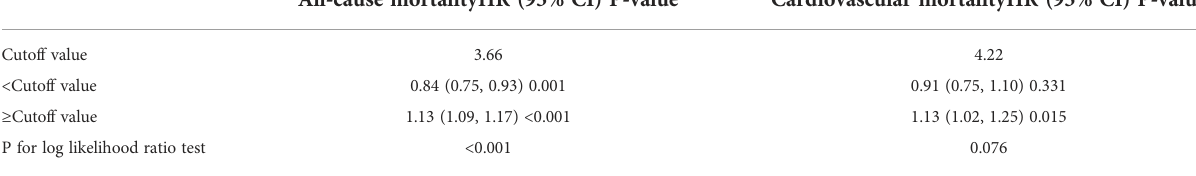
TABLE 3 The results of two-piecewise linear regression model between the TC/HDL-C ratio and all-cause mortality and cardiovascular mortality. All-cause mortalityHR (95% CI)